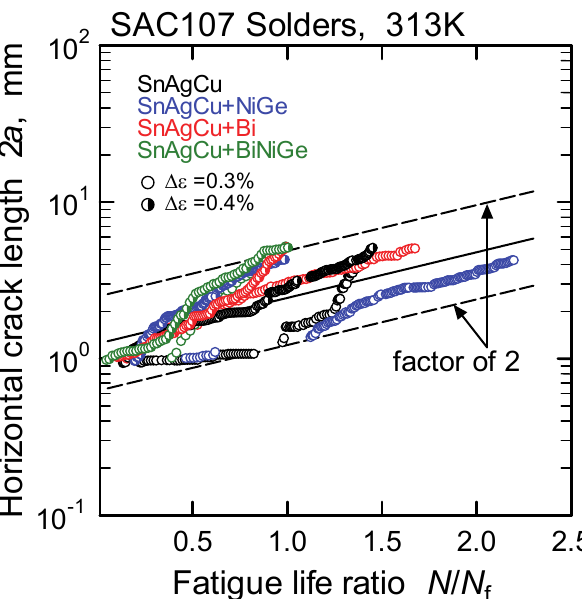
Figure 6: Crack length as a function of fatigue life ratio.